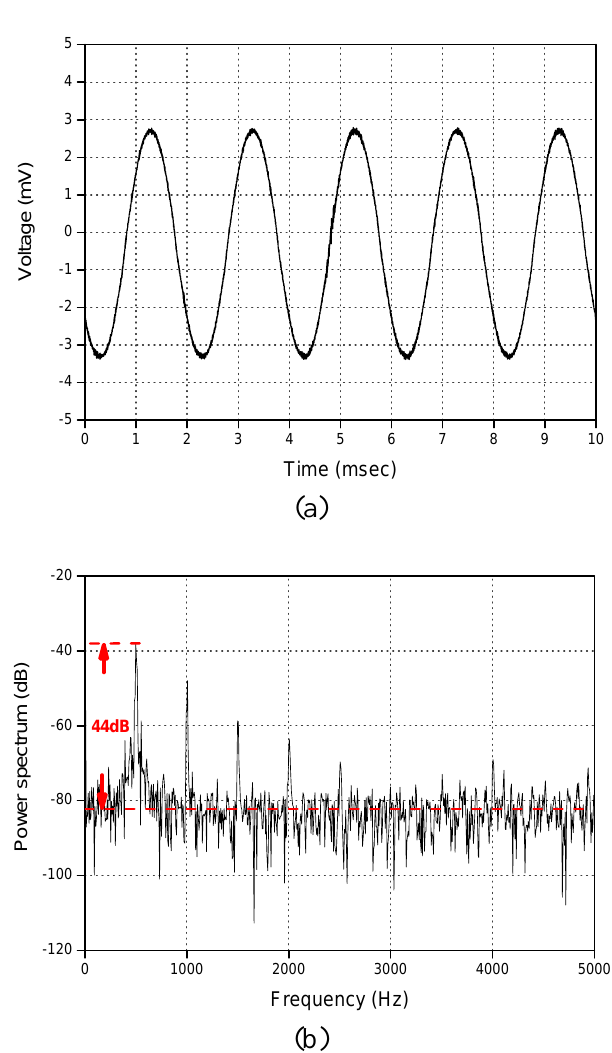
Figure 10. Measured sensor output signal of fabricated MMIS at magnetic flux density of 0.05 mT, frequency of 500 Hz and angle between magnetic field and ammunition rotation axis of 90°: (a) Voltage output; (b) Power spectrum output.